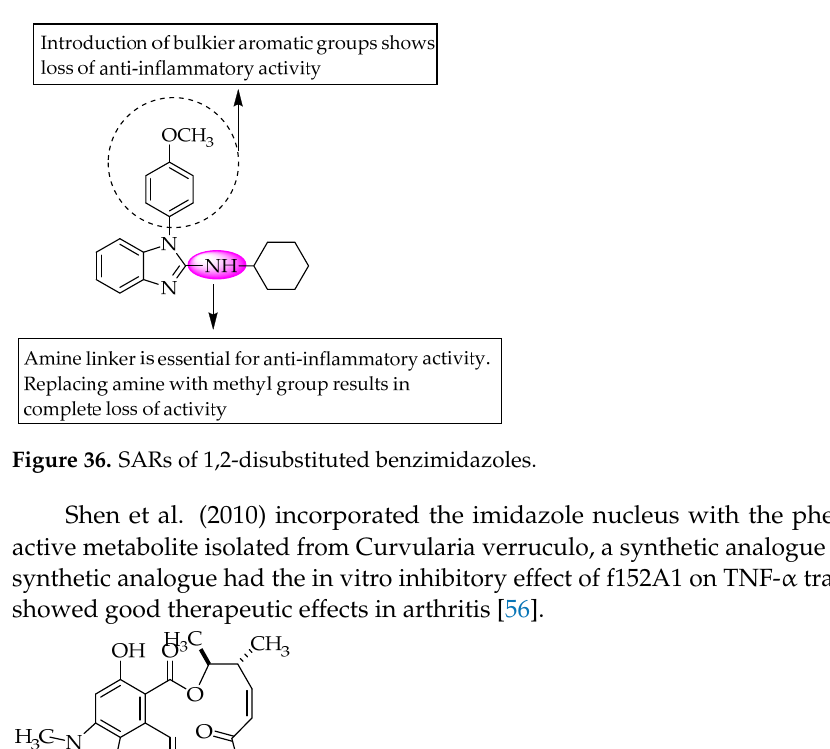
synthetic analogue had the in vitro inhibitory effect of f152A1 on TNF- α transcription